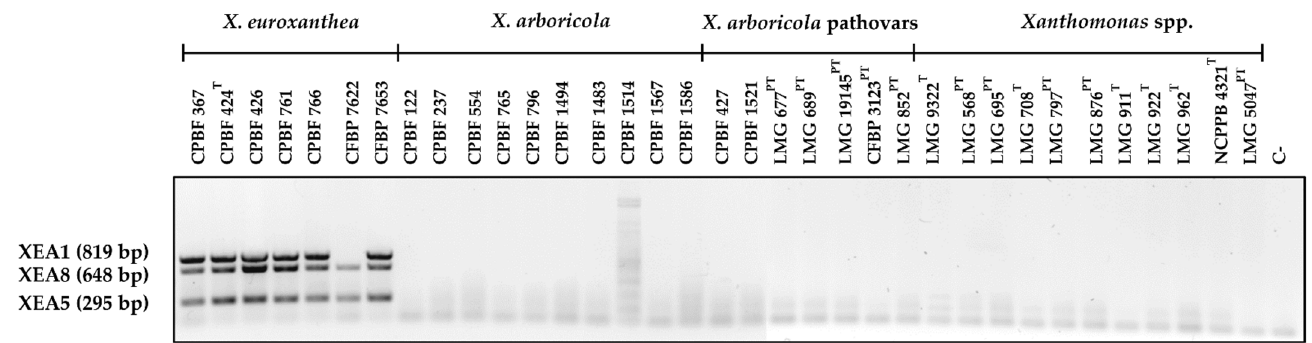
Figure 5. Multiplex PCR using Xanthomonas euroxanthea -specific DNA markers XEA1 (819 bp), XEA8 (648 bp) and XEA5 (295 bp) on 7 X. euroxanthea strains, 10 Xanthomonas arboricola strains, 6 pathovars of Xanthomonas arboricola and 9 non- arboricola Xanthomonas species. Markers XEA5 and XEA8 were successful in detecting X. euroxanthea strains, while XEA1 identified all X. euroxanthea strains, except